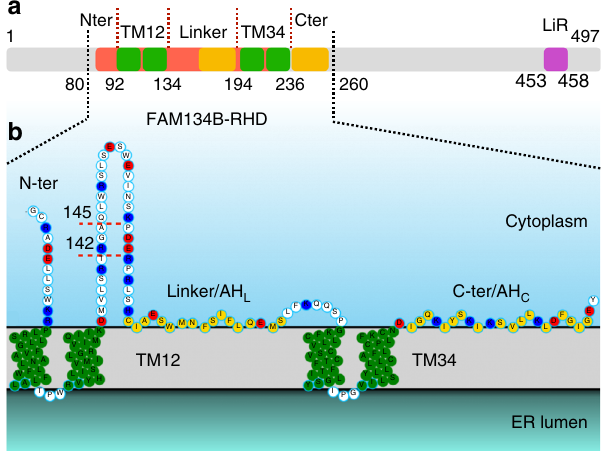
Fig. 1 Sequence and topology of FAM134B. a Schematic of the full length FAM134B sequence. The RHD consists of two transmembrane segments (green, TM12 and TM34) separated by a 60-residue linker, and two additional terminal segments. The C-terminal fragment of the RHD and the linker-helix (yellow) form conserved amphipathic helices. b Topology of FAM134B-RHD (80 – 260). Charged residues (K/R blue and D/E red), TM segments (green) and amphipathic helices (yellow) are highlighted. Genetic variant Q145X and proteolytic cleavage product R142X result in truncated proteins (red dotted line) disrupting the RHD. The N-terminal and C-terminal disordered regions (not modeled, gray) fl ank the RHD on the cytosolic face of the ER